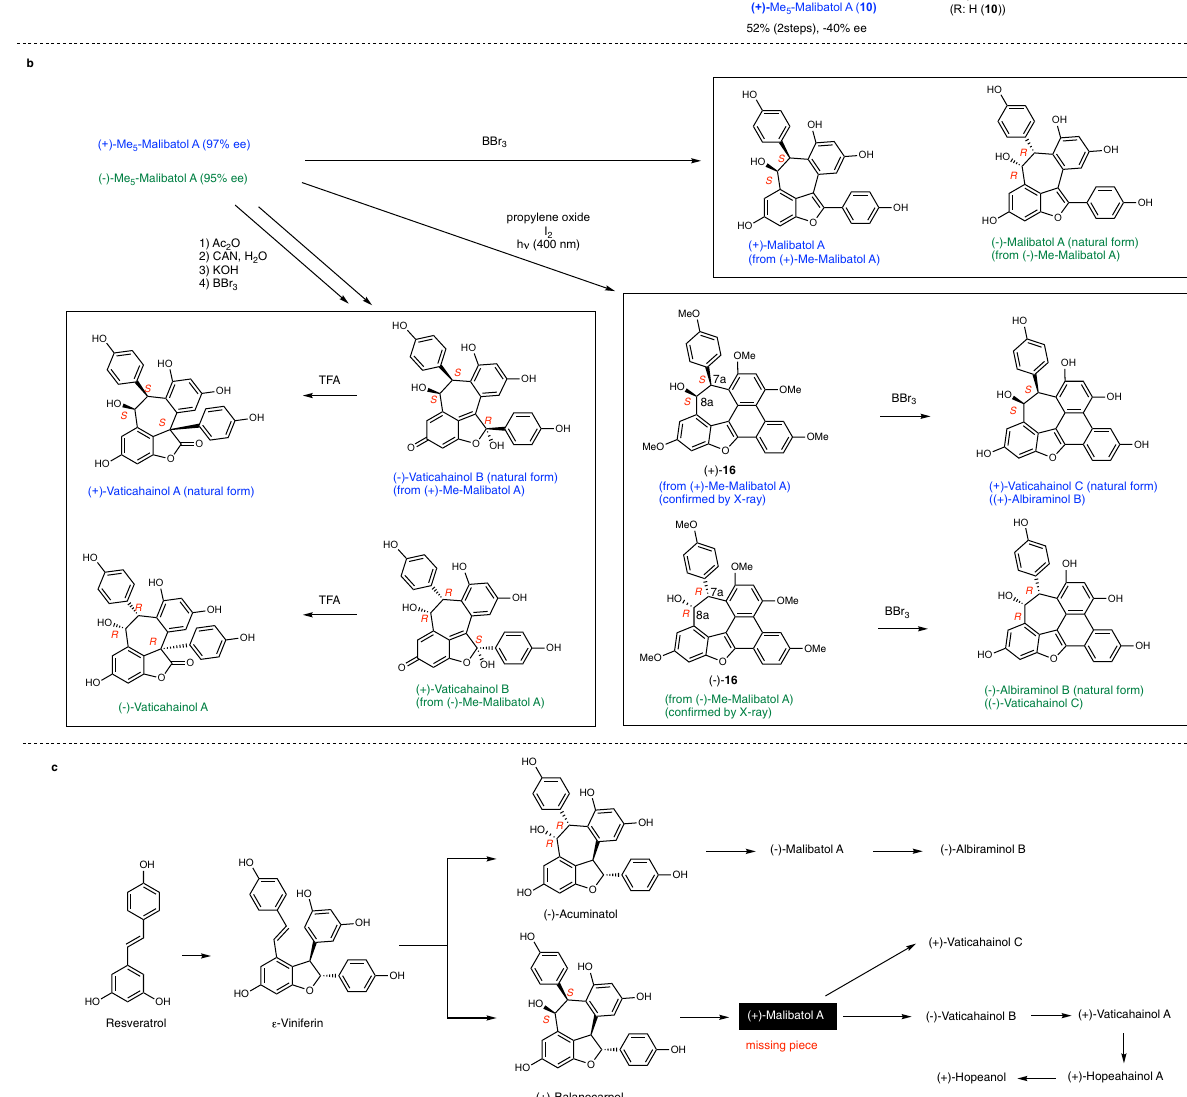
Fig. 5 Kinetic resolution and asymmetric total syntheses of resveratrol dimers. a Kinetic resolution of (±)-Me 5 -malibatiol A ( 10 ) to obtain optically active ( + )- 10 and ( − )- 10 . b Asymmetric total syntheses of ( + )- and ( − )- resveratrol dimers and determination of their absolute con fi gurations. c Proposed biosynthetic pathways. DIPEA N,N-diisopropylethylamine, ee enantiomeric excess.